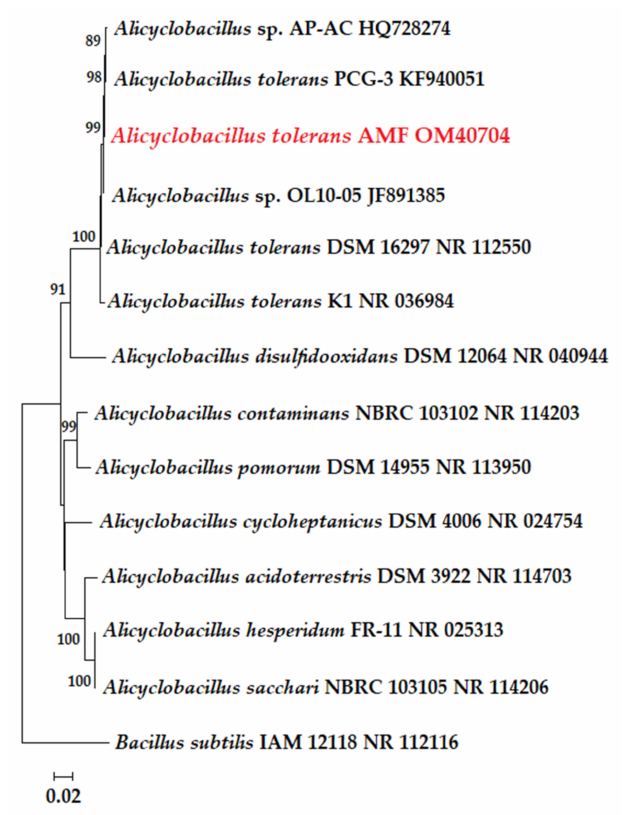
Figure 2. Dendrogram of Alicyclobacillus strains showing the phylogenetic position of Al. tolerans AMF, according to the 16S rRNA gene sequences. The phylogenetic tree was constructed using MEGA 11 [20]. The evolutionary history was inferred using the Neighbor-Joining method [21]. The percentage of replicate trees in which the associated taxa clustered together in the bootstrap test (1000 replicates) is shown next to the branches [22]. The bootstrap values of ≥ 80 are shown. The tree is drawn to scale, with branch lengths in the same units as those of the evolutionary distances used to infer the phylogenetic tree. The evolutionary distances were computed using the Maximum Composite Likelihood method [23] and are in the units of the number of base substitutions per site. This analysis involved 14 nucleotide sequences. There were a total of 1558 positions in the final dataset. Bacillus subtilis IAM 12118 was used as an